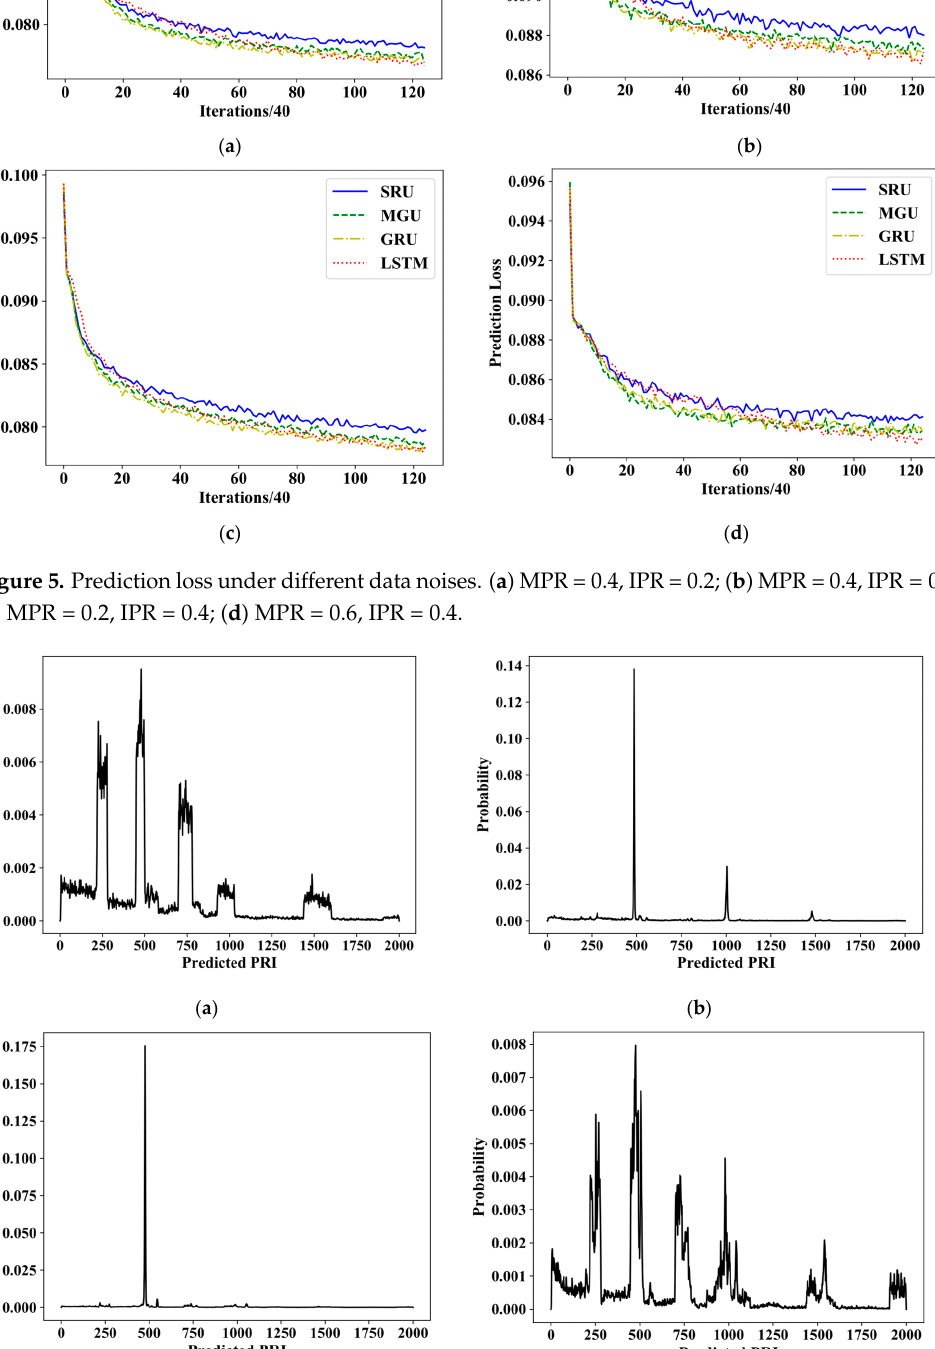
Figure 6. Prediction spectrum of LSTM under different inputs when MPR is 0.4 and IPR is 0.4. ( a ) the first input 0; ( b ) the second input 456 us; ( c ) the forth input 516 us; ( d ) the fifth input 476 us.